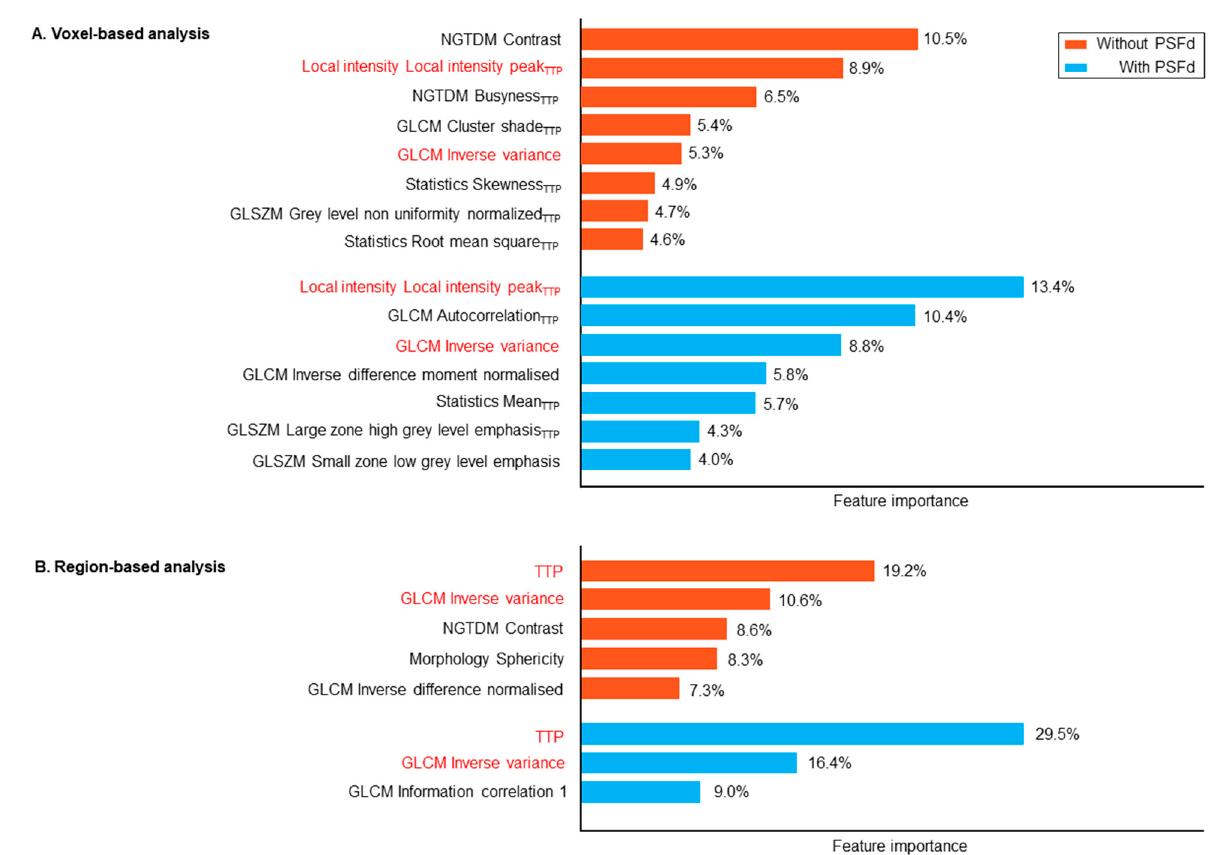
Figure 4. Shapley additive explanation (SHAP) values representing feature importance to substantiate at least 50% of the 1p/19q codeletion prediction model (for voxel-based ( A ) and region-based ( B ) analysis) trained on the static/dynamic feature set. Common features between the two PSFd statuses are highlighted in red. Subscript TTP indicates that the relevant feature is extracted from the dynamic TTP parametric map. PSFd: point spread function deconvolution; TTP: time-to-peak; NGTDM: neighborhood grey tone difference matrix; GLCM: grey level co-occurrence matrix; GLSZM: grey level size zone matrix.